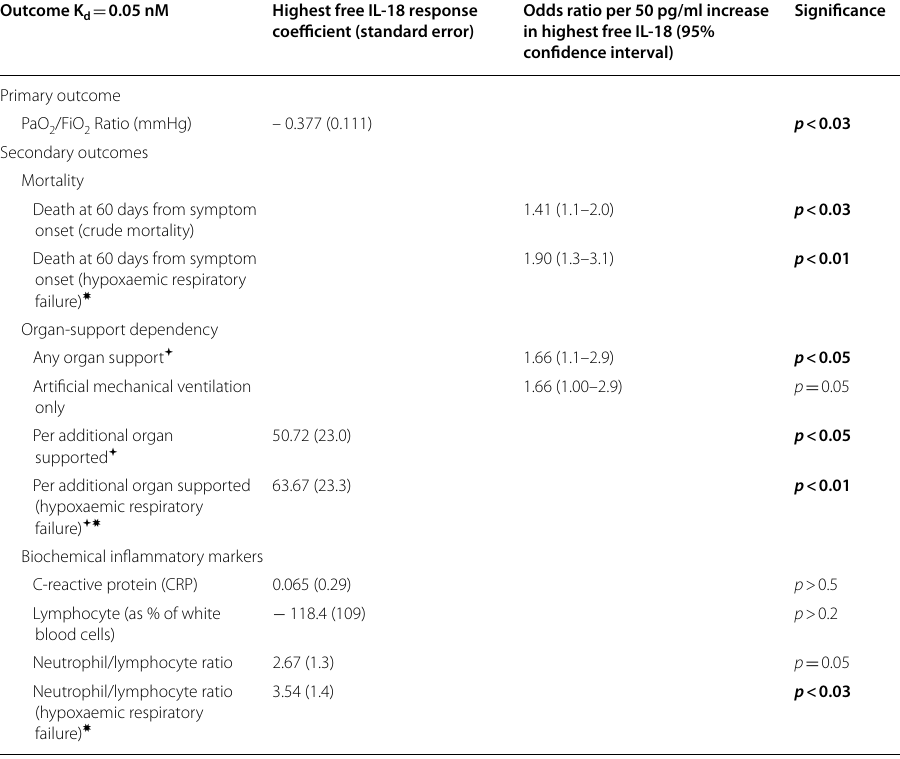
Results that reach the significance threshold are bolded ✸ The “hypoxaemic respiratory failure group” excludes 4 patients whose calculated PaO2/FiO2 ratio from values recorded in the last 24 h of life did not fall below 300 mmHg at any time. The group is used to exclude those who died from causes other than hypoxaemic respiratory failure ✦ “Per Additional Organ supported” refers to each new organ supported, out of: vasopressor support; artificial mechanical ventilation; renal replacement